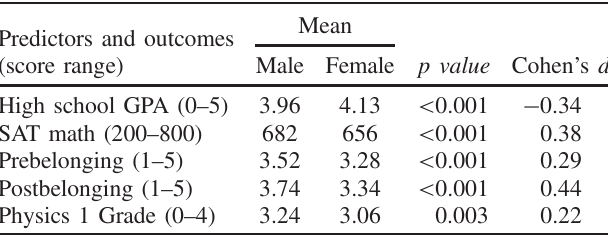
TABLE II. Mean predictor and outcome values by gender as well as statistical significance ( p values) and effect sizes (Cohen ’ s d ) by